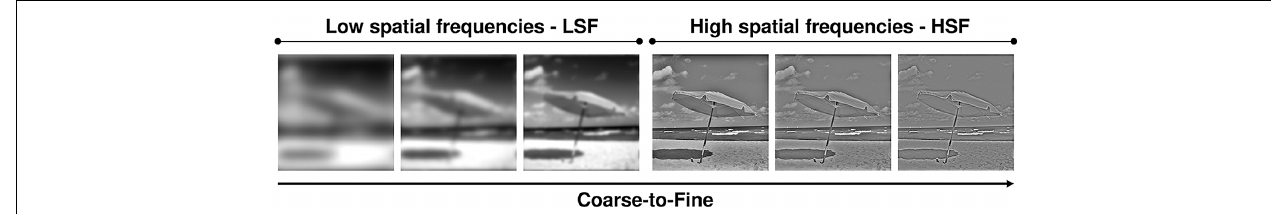
FIGURE 1 | Coarse-to-fine sequence of spatial frequency processing (from low-to-high spatial frequencies) during scene